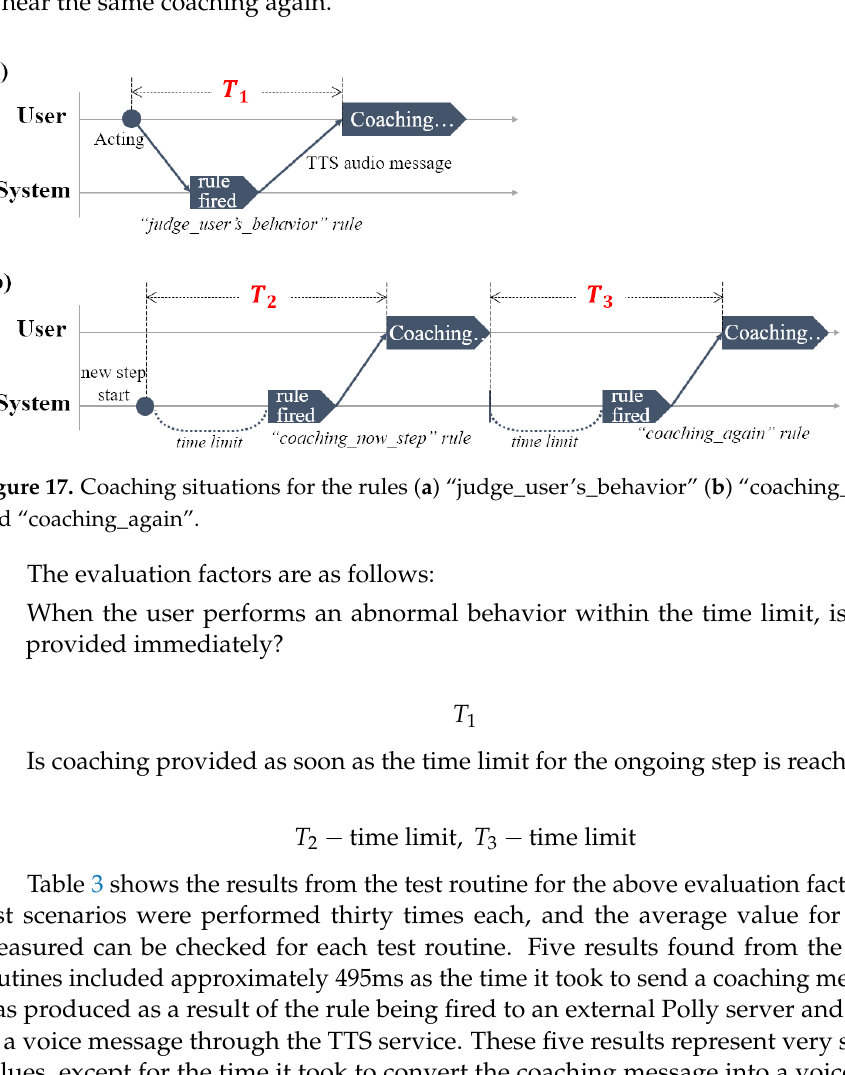
Table 3. Performance evaluation results for the coaching timing measurement.